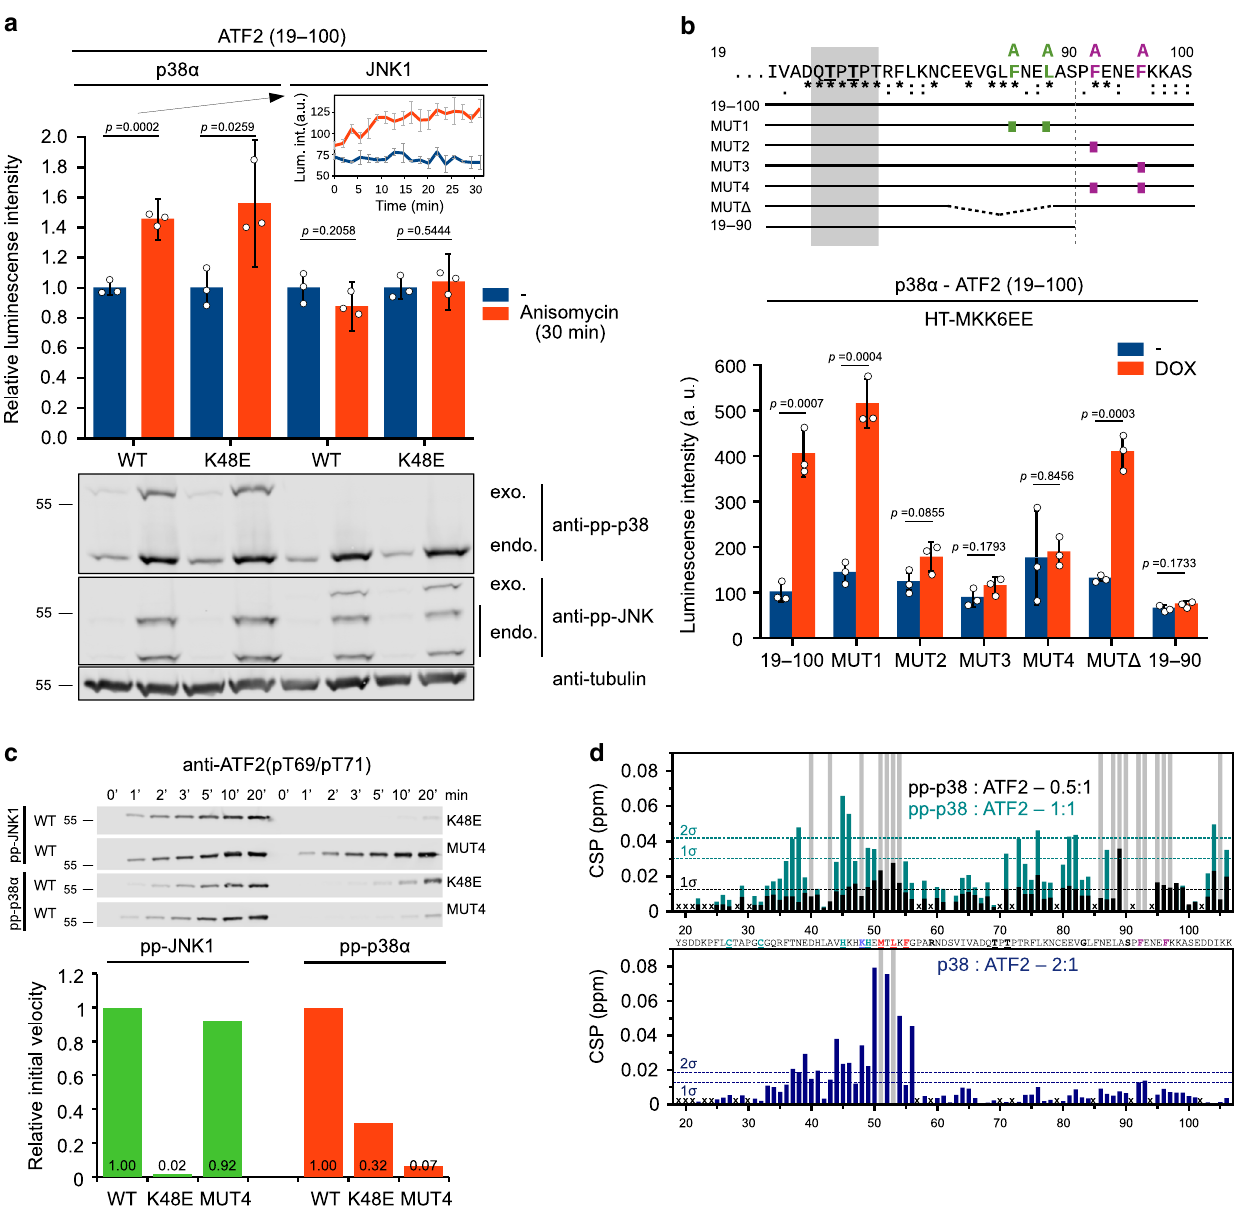
Fig. 3 p38 mediated binding and phosphorylation of ATF2 TAD. a Luciferase complementation assay (NanoBit) on p38-ATF2 and JNK1-ATF2 binding in HEK293T cells. The impact of p38 and JNK activation by anisomycin and the K48E mutation were examined. Luminescence signal change upon MAPK activation was monitored in time after addition of anisomycin (see inset for p38:WT-ATF2 binding). Complex formation between p38 α or JNK1 and ATF2 (19 – 100) was measured after the addition of the luciferase substrate Coelenterazine h (at 30 min) and luminescence values obtained in the presence of anisomycin (red) were normalized to control ( − ; blue). MAPK activation was con fi rmed by anti-phosphoMAPK (anti-pp-p38 or anti-pp-JNK) western- blots. (endo: endogenous MAPKs; exo: luciferase fragment tagged MAPK probe). Anti-tubulin antibody was used to demonstrate equal sample load. Error bars show SD calculated based on three technical replicates. Bar charts show data points with mean ± SD and p -value, two-sided unpaired t -test. b Mapping critical amino acid residues for pp-p38-ATF2 TAD binding in HEK293T cells. The luciferase complementation based NanoBit assay was used to test the binding of p38 and different ATF2 TAD (19 – 100) mutants. Selective activation of p38 was achieved by doxycycline (DOX) addition in HT-MKK6- EE cells: DOX induces the expression of MKK6EE, which is the upstream activator kinase of p38. Error bars show SD calculated based on three technical replicates. Bar charts show data points with mean ± SD and p -value, two-sided unpaired t -test. c In vitro phosphorylation of ATF2 TAD constructs. JNK1 or p38 α mediated phosphorylation of two ATF2 TAD (19 – 100) constructs (K48E and MUT4) were compared to wild-type (WT). ATF2 TAD phosphorylation was detected by using anti-phosphoT69/71 antibody in western-blots. d Interaction region mapping by NMR. 15 N-labeled ATF2(19 – 106; 100 µ M) was mixed with pp-p38 (upper panel) or nonphosphorylated p38 (lower panel) in different molar ratio. Histograms show the 1 H/ 15 N chemical shift perturbations (CSPs) vs residue number (for intensity changes upon binding see Supplementary Fig. 5b). Dashed lines indicate CSPs corresponding to 1 ϭ or 2 ϭ changes. Residues displaying line broadening are indicated by gray bars. ‘ x ’ indicates resonances of residues that were not resolved in the spectra and therefore could not be quanti fi ed or prolines. Source data are provided as a Source data fi